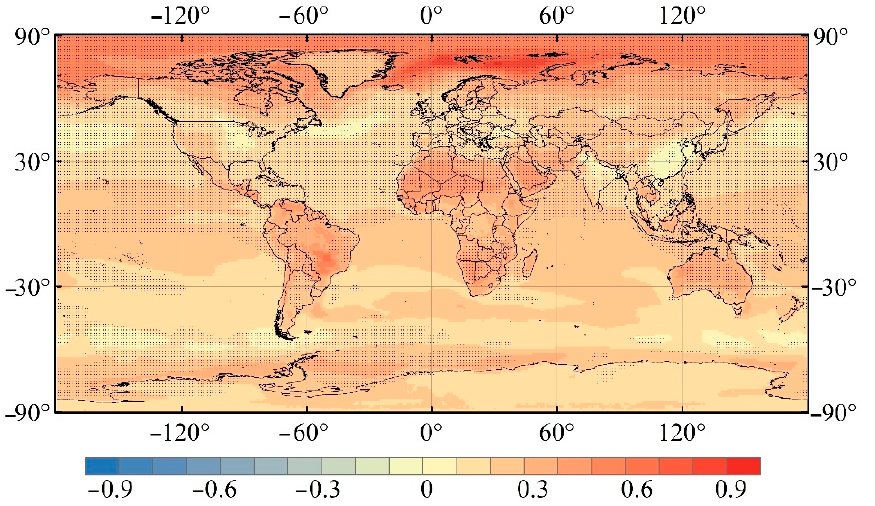
Figure 10. The annual variations in anomalous global mean SULR of the ERA5, CERES EBAF, and the BMA results of the CMIP6 and CMIP5 GCMs.